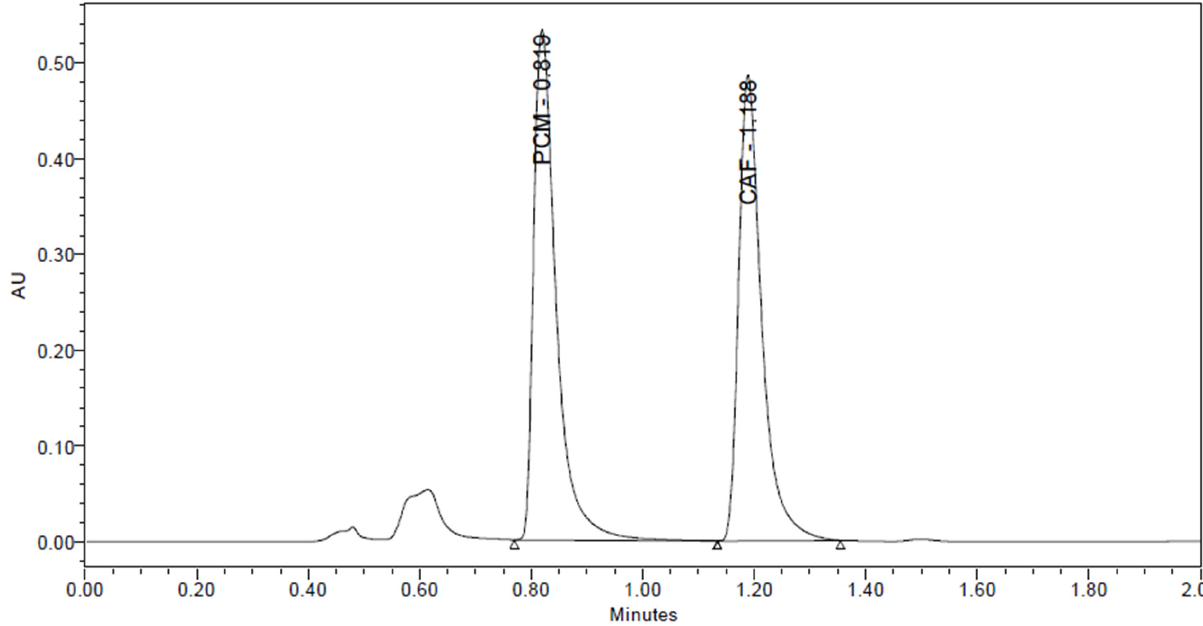
Figure 10. Chromatogram of PCM and CAF for wet heat degradation.